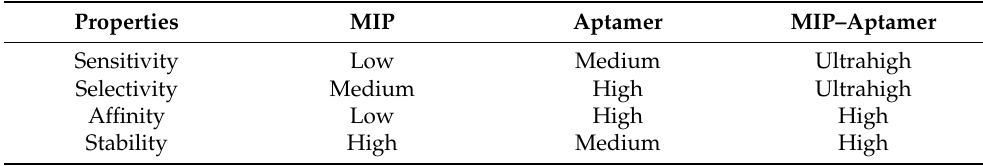
Table 1. Comparison of MIP, aptamer and MIP-aptamer.